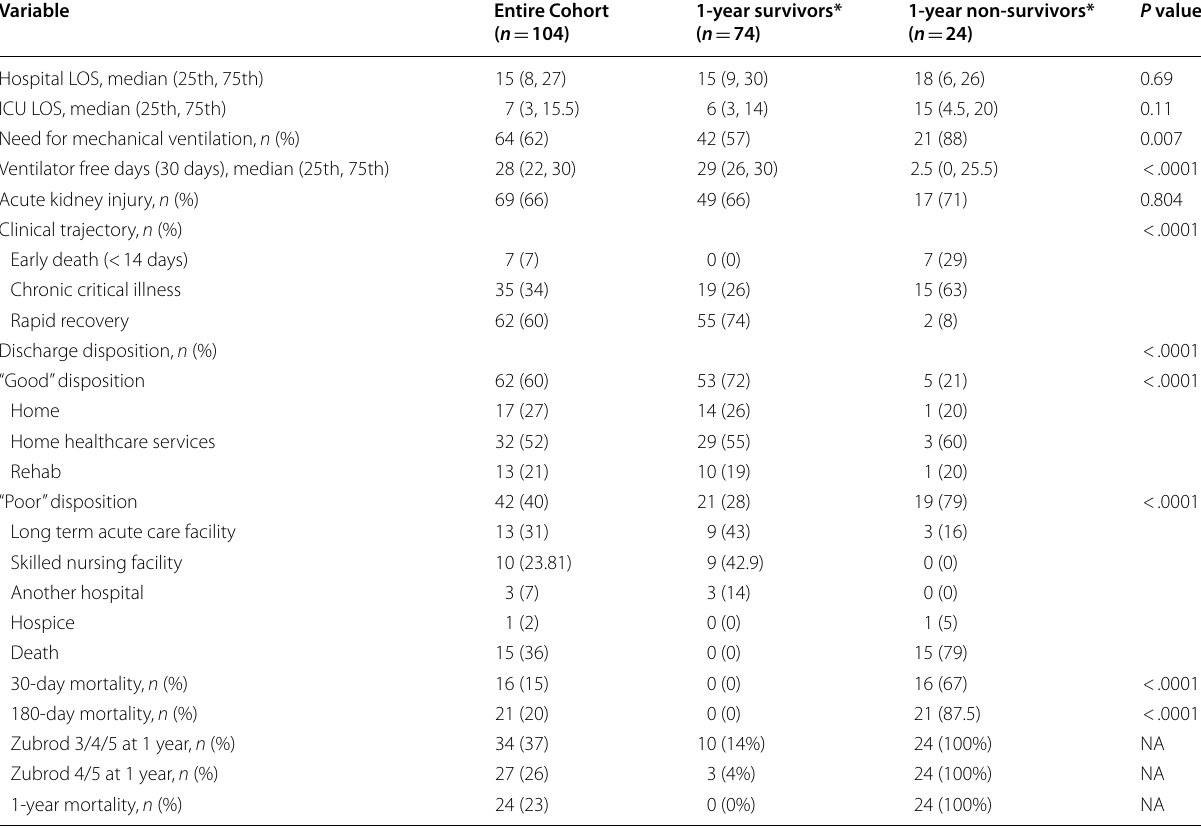
*indicate that 6 patients were lost to follow up and did not have data on 1-year survival